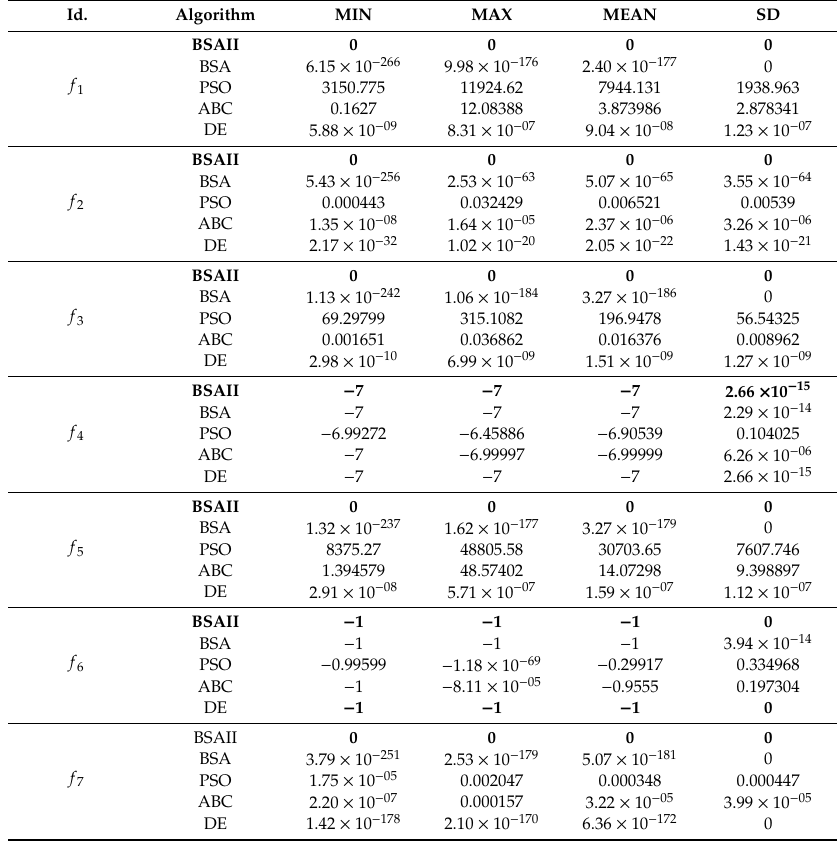
Figure 4. Convergence of benchmark functions using BSAII, BSA, particle swarm optimization (PSO), artificial bee colony (ABC) and di ff erential evolution (DE). Table 6. Statistical results obtained by BSAII, BSA, PSO, ABC, and DE in 50 trails (the best results are in